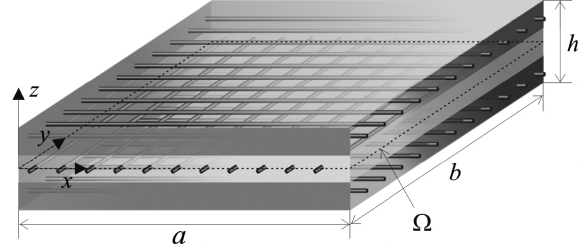
Fig. 1. Reference system and plate